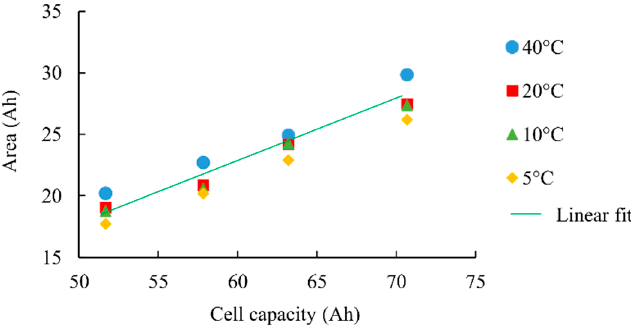
Figure 12. Measured area function of cell capacity for various temperatures and with pause before peak 2 (C/3-100% DoD).